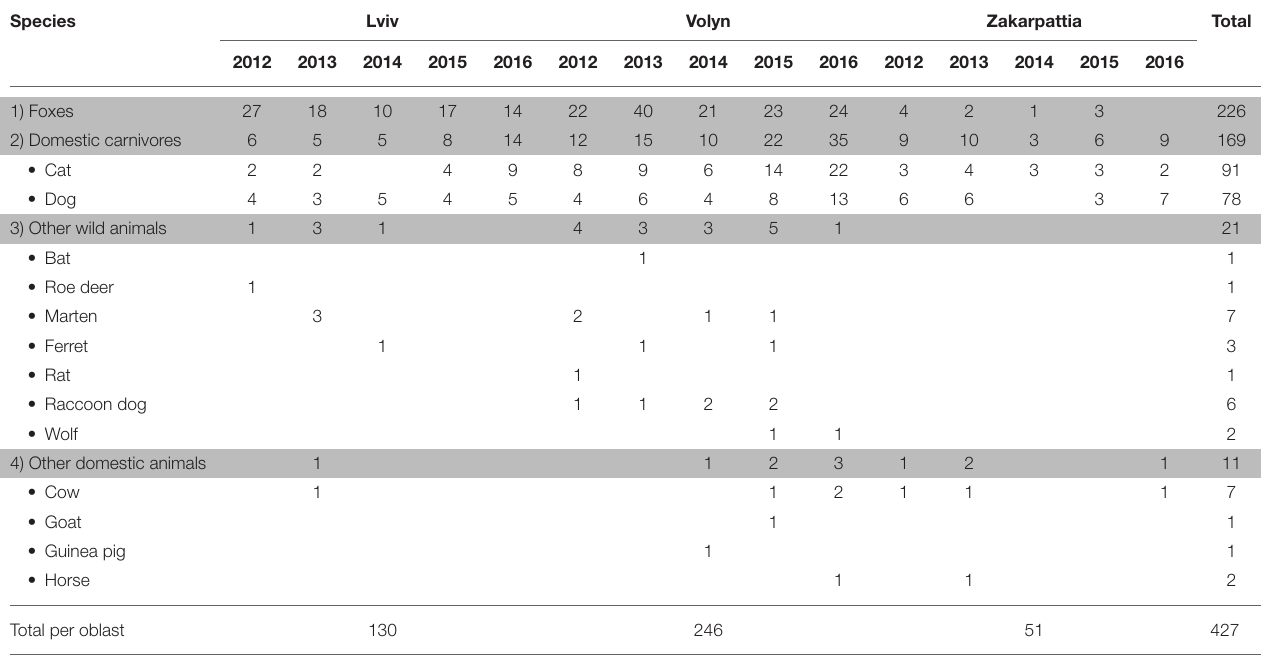
TABLE 1 | Rabies cases in Lviv, Volyn, and Zakarpattia oblasts 2012–2016. Species